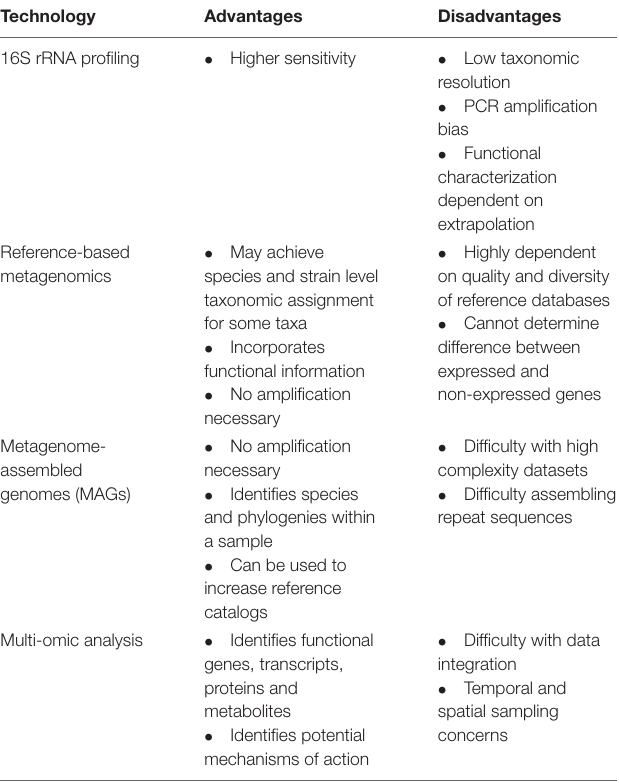
TABLE 1 | Advantages and disadvantages of available taxonomic and functional characterization